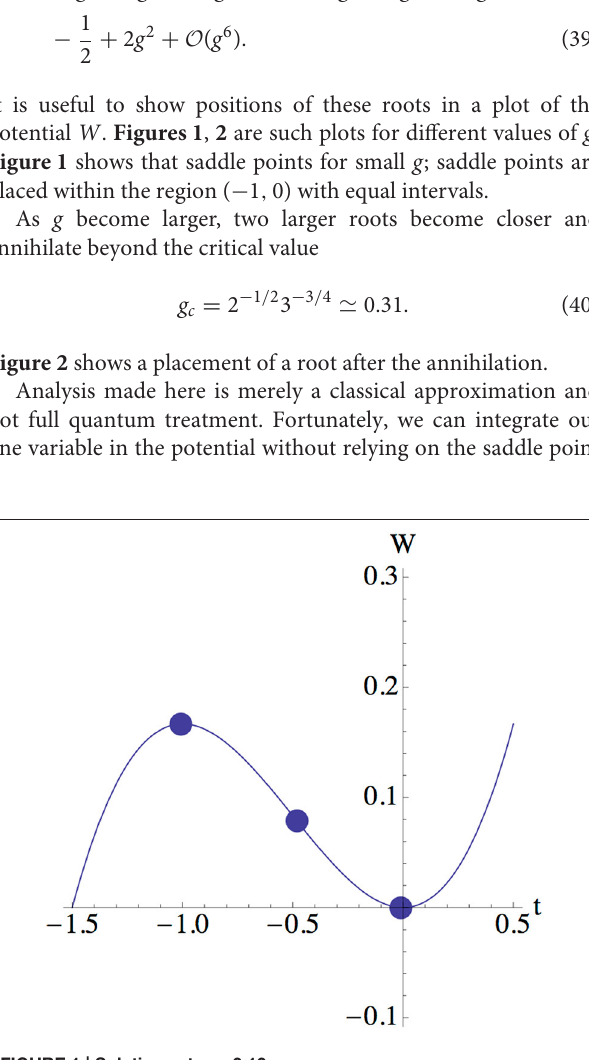
FIGURE 1 | Solutions at g =